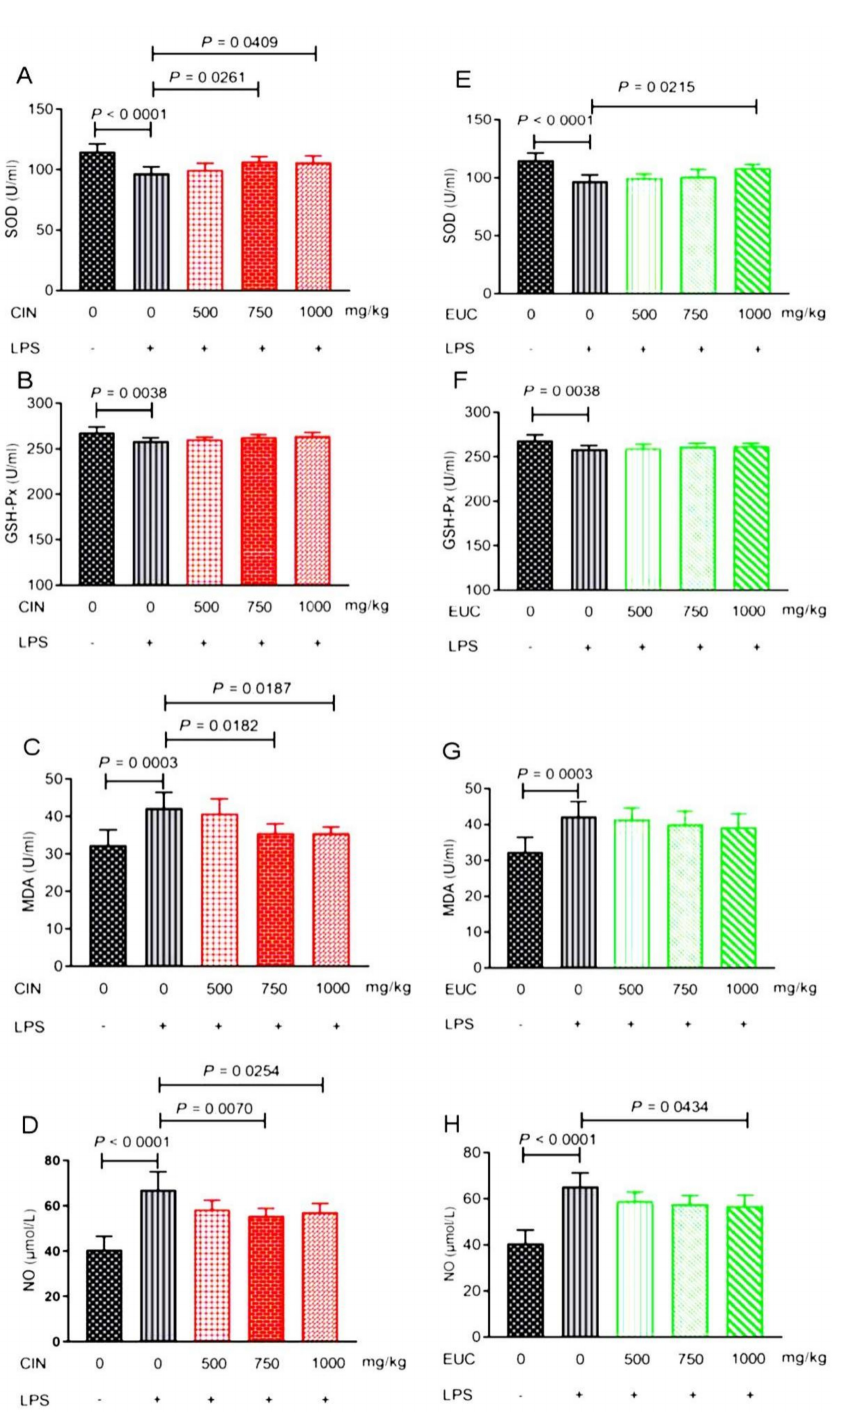
Figure 1. Effect of EOs on antioxidant indexes of serum in mice induced by LPS. Effects of cinnamon oil on LPS-induced production of superoxide dismutase (SOD) ( A ), glutathione peroxidase (GSH-Px) ( B ), malondialdehyde (MDA) ( C ), and nitric oxide (NO) ( D ) in mice. Effects of eucalyptus oil on LPS-induced production of SOD ( E ), GSH-Px ( F ), MDA ( G ), and NO ( H ) in mice. Data are presented as mean ± standard error of measurement (mean ± SEM) ( n = 6). The concentration of LPS induced in mice was 10 mg/kg. The concentration of cinnamon oil and eucalyptus oil were 500 mg/kg, 750 mg/kg, and 1000 mg/kg, respectively. CIN—cinnamon oil; EUC—eucalyptus